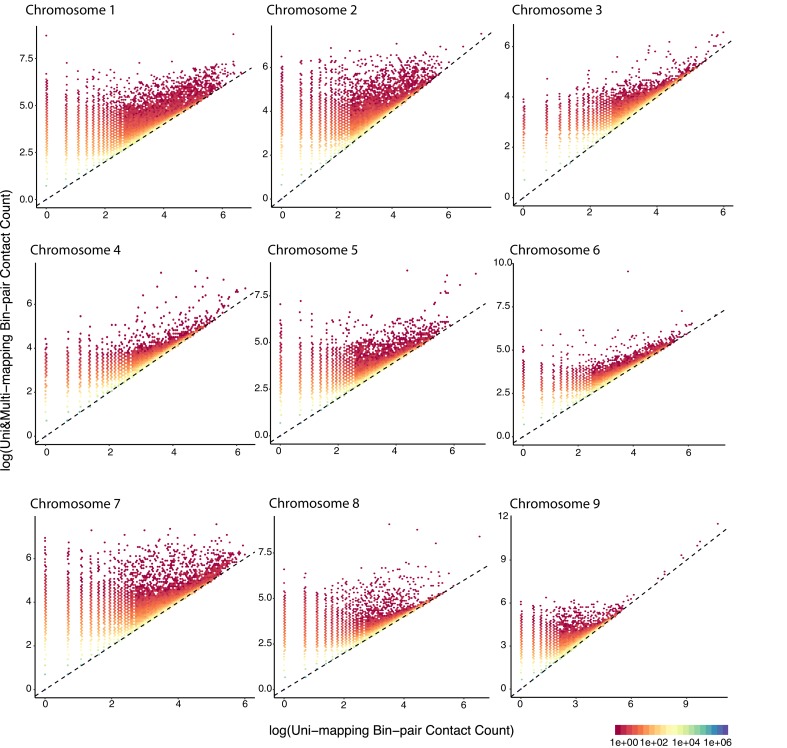
Bin coverage improvement of raw contact matrices under Uni&Multi-setting compared to Uni-setting for GM12878 with combined reads from replicates 2–9 at 5 kb.Only chromosome 1–9 are shown and the pattern for the rest chromosomes are very similar. The dashed line is y = x.